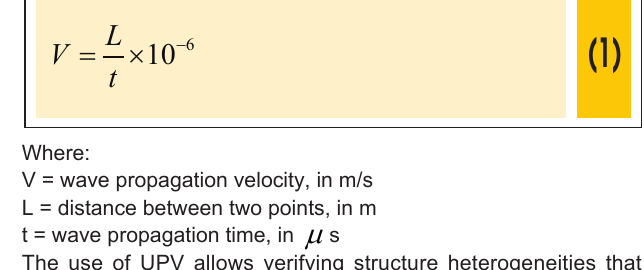
Figure 1 – Aspect of the performance of an UPV